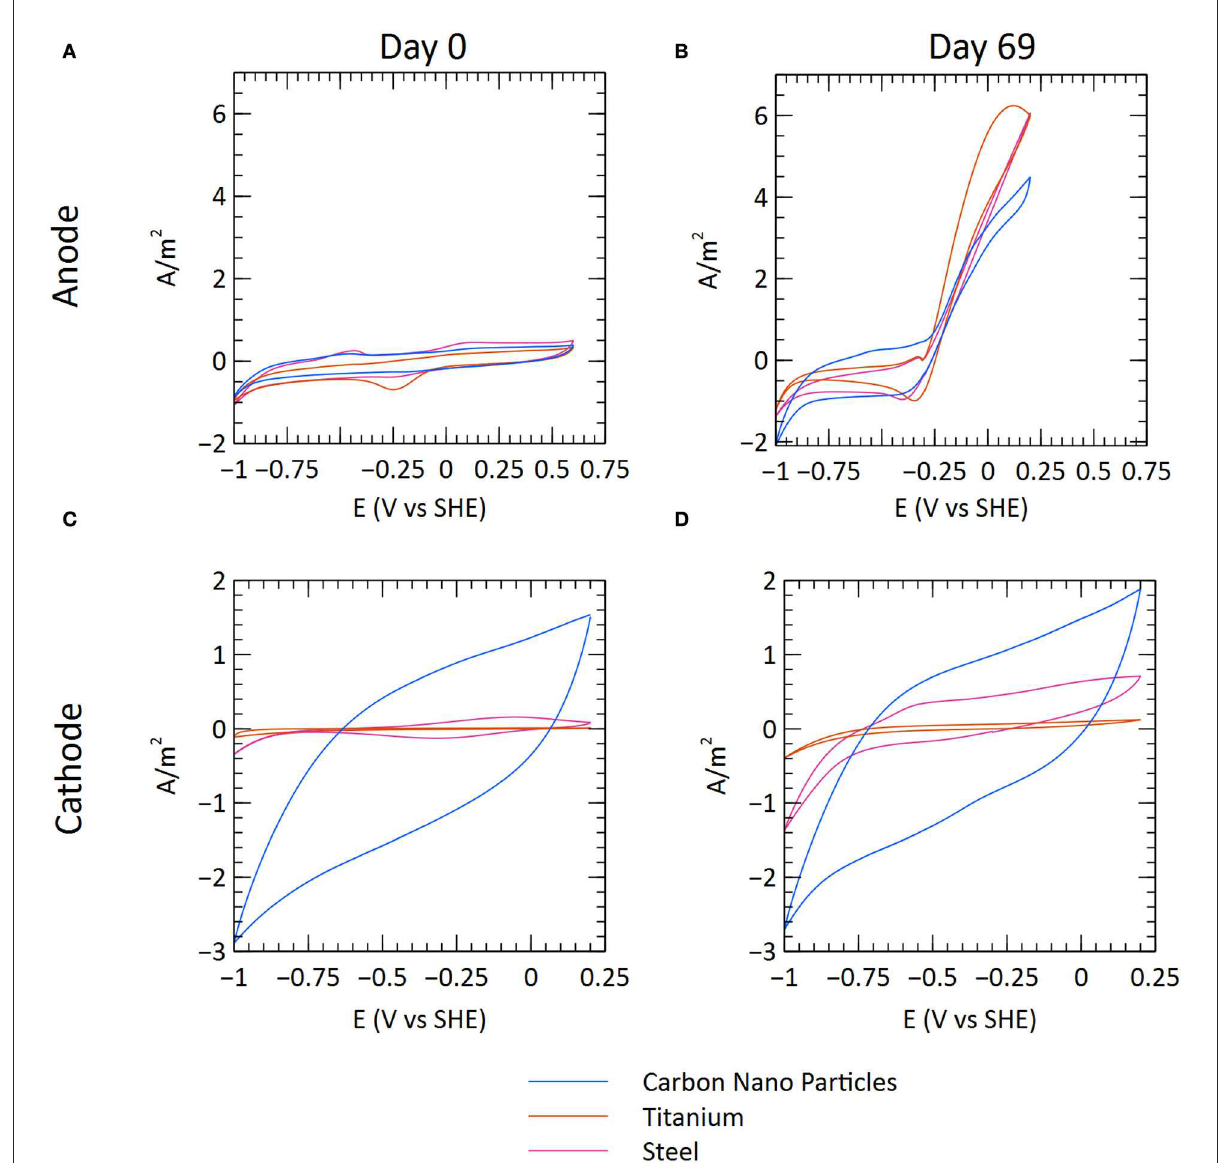
FIGURE3 Cyclic voltammetry measurements from the start (after inoculation) and end of the experiment. The graphs illustrate a representative MEC for each material (C1, T3, and S2). (A) Anode at the start of the experimental run. (B) Anode at the end of the experimental run. (C) Cathode at the start of the experimental run. (D) Cathode at the end of the experimental